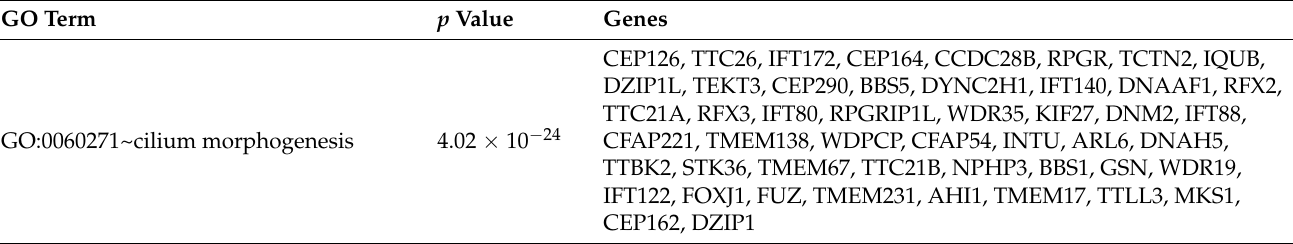
Table 2. Pathways upregulated in IPF ciliated